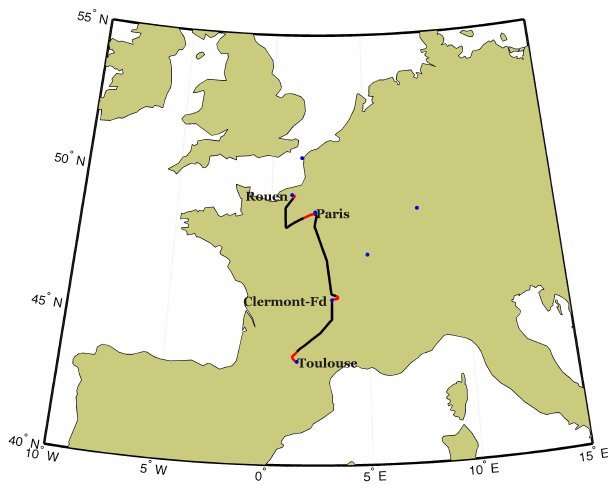
Fig. 11. ATR-42 trajectory on 22 April. Boundary layer measure- ment periods are highlighted in